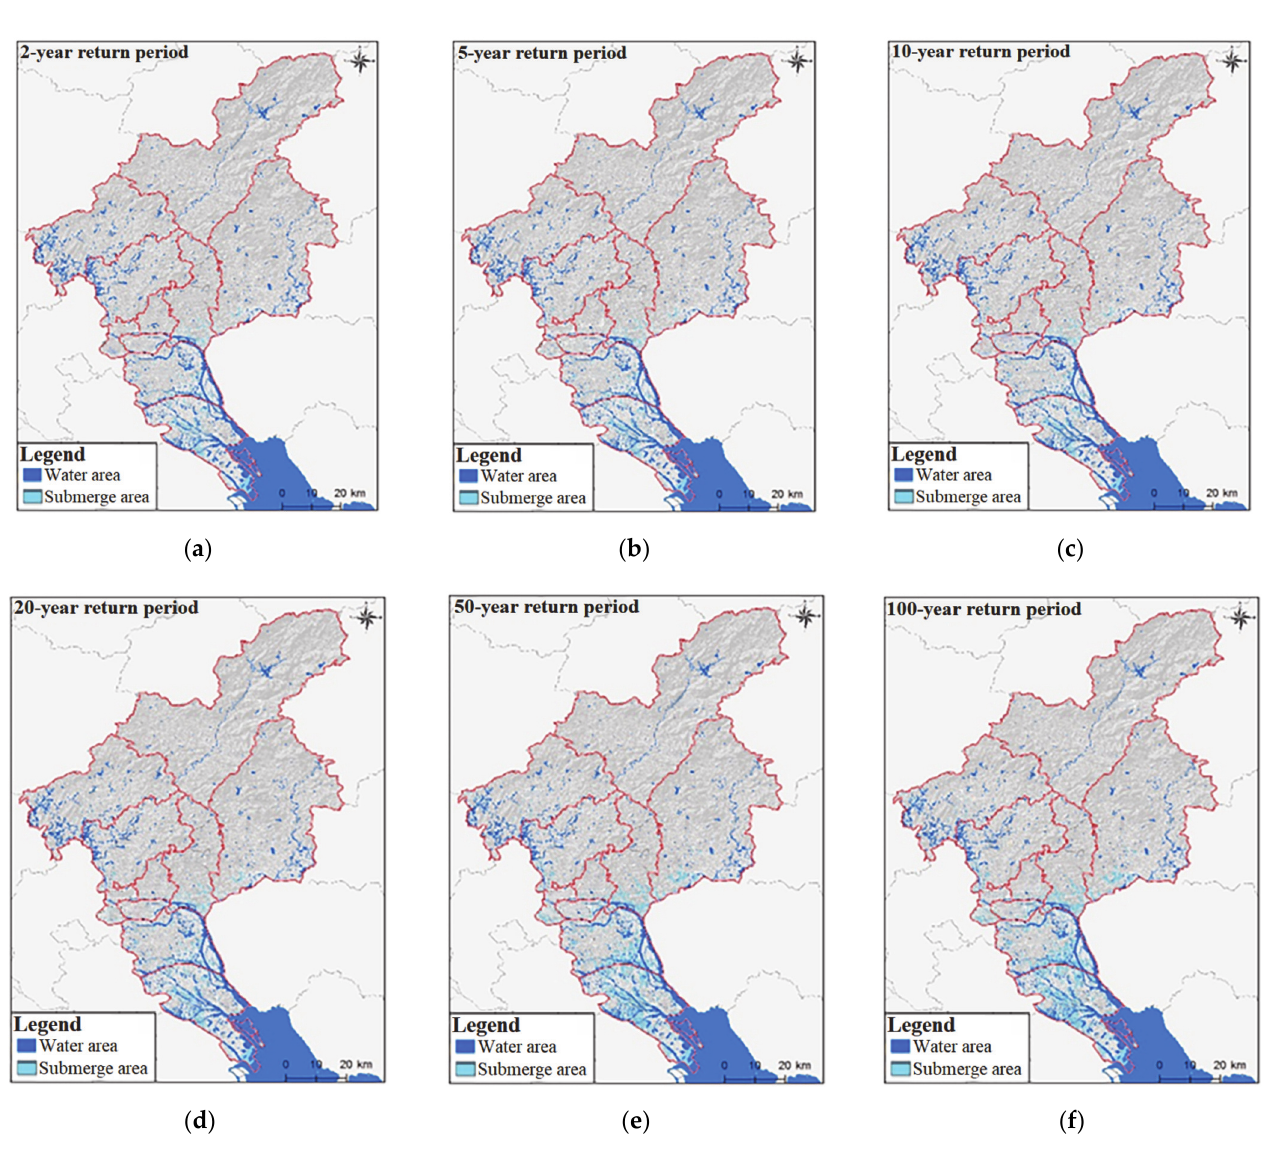
Figure 6. Inundation range under different precipitation scenarios: ( a ) 2-year return period; ( b ) 5-year return period; ( c ) 10-year return period; ( d ) 20-year return period; ( e ) 50-year return period; ( f ) 100-year return period. Table 5. Waterlogging volume and inundation elevation in different rainfall return periods.